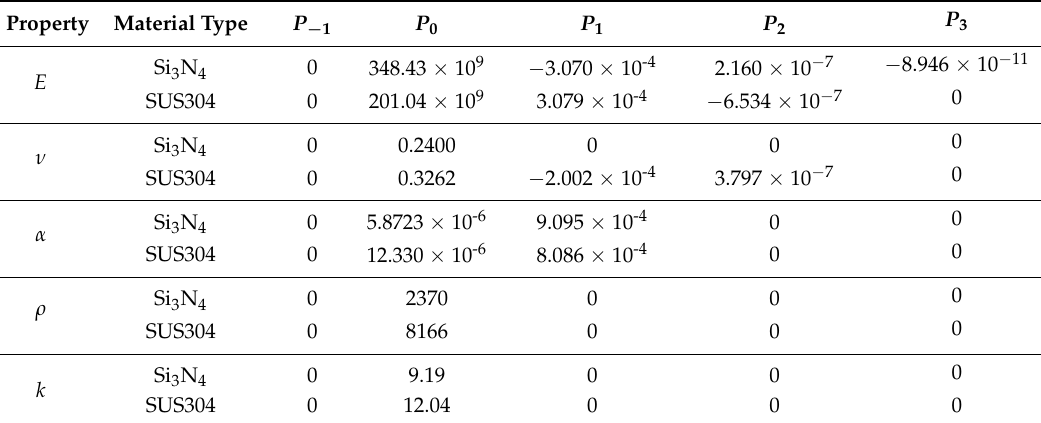
Table 5. Critical buckling temperature Δ T cr of SSSS type ‐ II FGM square plate with different a / h under a uniform temperature field ( a / b = 1).